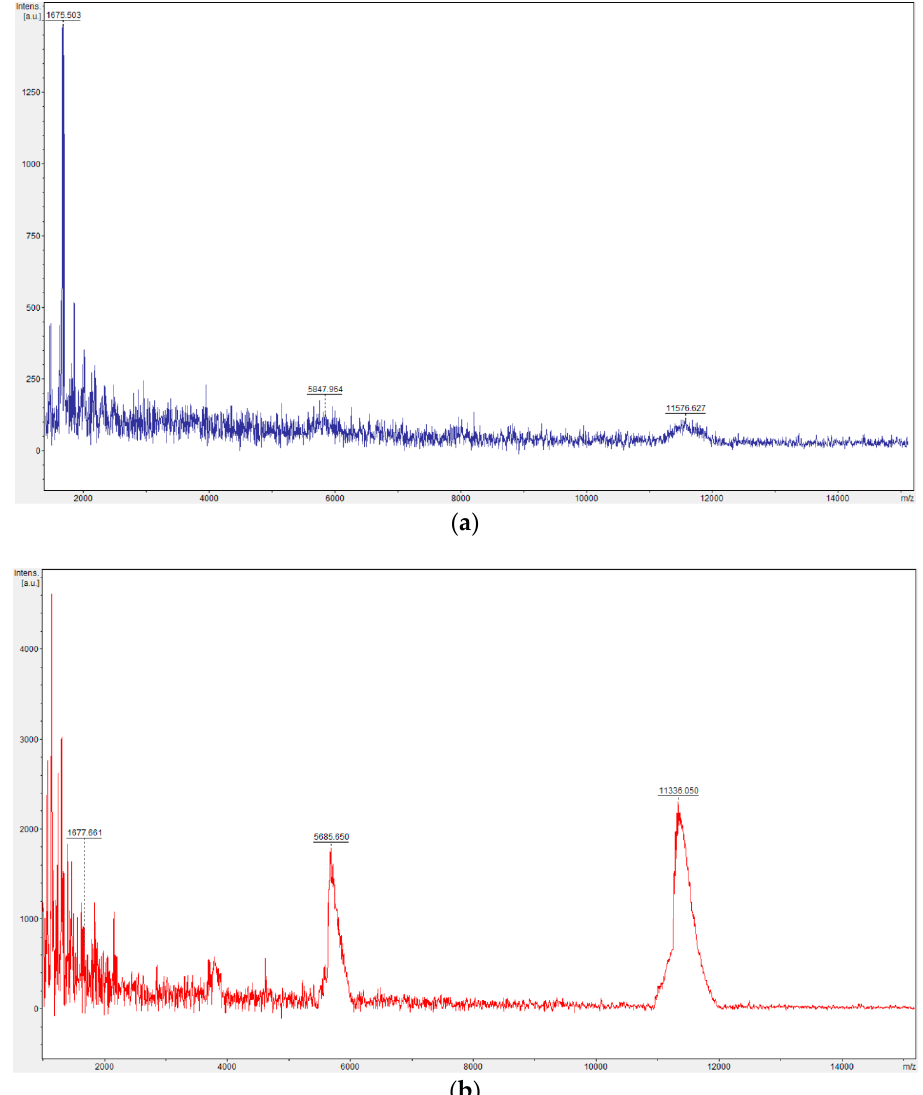
Figure A3. Comparison of mass spectra of oligonucleotides coupled to one SWL peptide. Mass spectra were obtained by using an Autoflex Speed mass spectrometer (Bruker Daltonik, Bremen, Germany) with 3-hydroxypicolinic acid matrix. ( a ) SWL-coupled oligonucleotides (30 nucleotides; expected mass 11.3 kDa) before purification with Amicon ® 3 K filter. Peak at 11.5 kDa confirms the covalent conjugation of SWL to oligonucleotides (double ionized peak at 5.8 kDa). Oligonucleotides, that were not coupled to SWL peptide, could not be detected (peak would be at 9.3 kDa). Peak at 1.7 kDa corresponds to free SWL peptide. This peak is relatively high in comparison to both DNA peaks. ( b ) Mass spectra of Amicon ® 3 K purified SWL-oligonucleotides. The ratio of SWL-oligonucleotides to uncoupled SWL shifted remarkably; the peak for free SWL is within the noise range whereas higher peaks are visible for DNA-SWL conjugates.